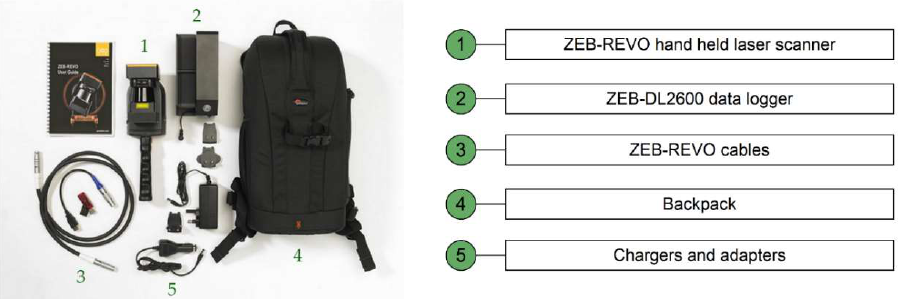
Figure 1. Main components of the wearable mobile laser systems (WMLS) used for data acquisition. Table 1. Technical specification of the Geo Simultaneous Localization and Mapping (SLAM) ZEB-REVO device.